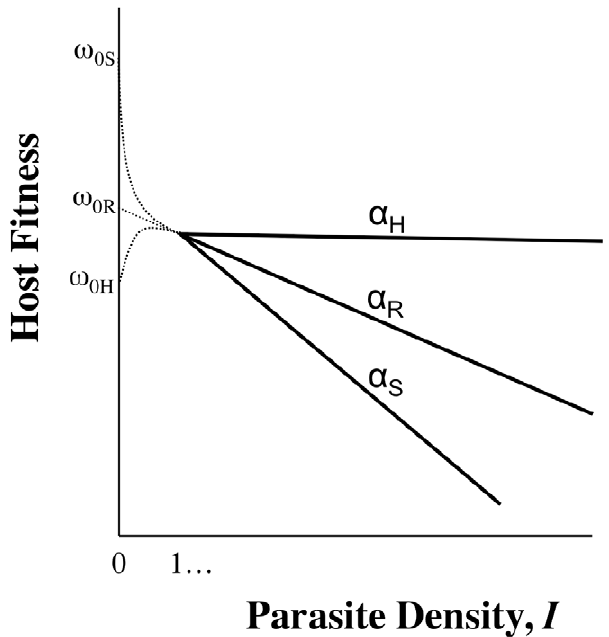
Figure 2. The importance of intercepts: pleiotropy. Host genotypes will almost certainly show differences in v o,n (genetic variation for life history characteristics is ubiquitous [37]), and in some cases these differences will be linked to variation in the traits that contribute to virulence ( a n or I n ) via pleiotropy (where one gene influences more than one trait). For example, hosts that possess alleles that confer more potent defences (ability to control I or a ) may be less fit when parasites are not around because the allele that aids defence compromises the performance of other traits (compare v oR and v oS ; R denotes resistance, S denotes susceptible). In other words, there may be a cost of possessing a defence mechanism [38], often referred to as a trade-off. It is even conceivable that v o,n is lower than host fitness at low I , because individuals without enough parasites can experience difficulty with immune regulation: the hygiene hypothesis posits that allergy and autoimmunity result from immune systems lacking direction from parasites ([39]; see v oH , which denotes hygiene). Thus, the rank order of v o,n may be the opposite of the rank order of fitness when infected. Moreover, v on may not be easily predicted from the relationship between parasite density and host fitness when infect- ed—for example, when just a small number of parasites stimulates a damaging or energy-sapping immune response that is little amplified by further infection. Generally, the fitness of uninfected individuals need not be a linear extrapolation of the relationship between fitness and parasite density ( I